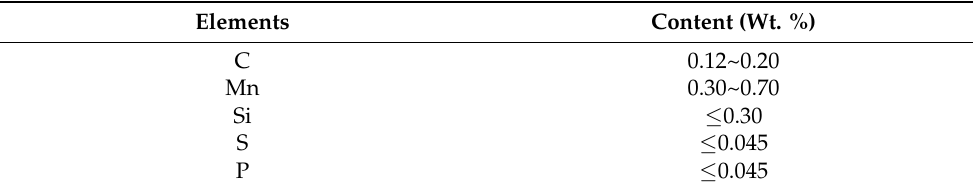
Table 1. Composition of Q235B low-carbon